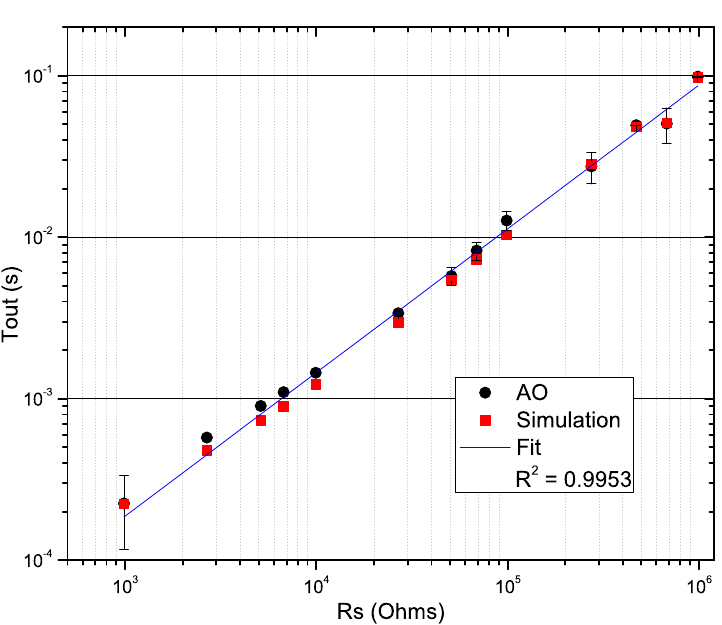
Figure 10. Period as function of the sample resistors. Simulation in solid red squares, experiment in solid black circles and linear Equation (5) in solid